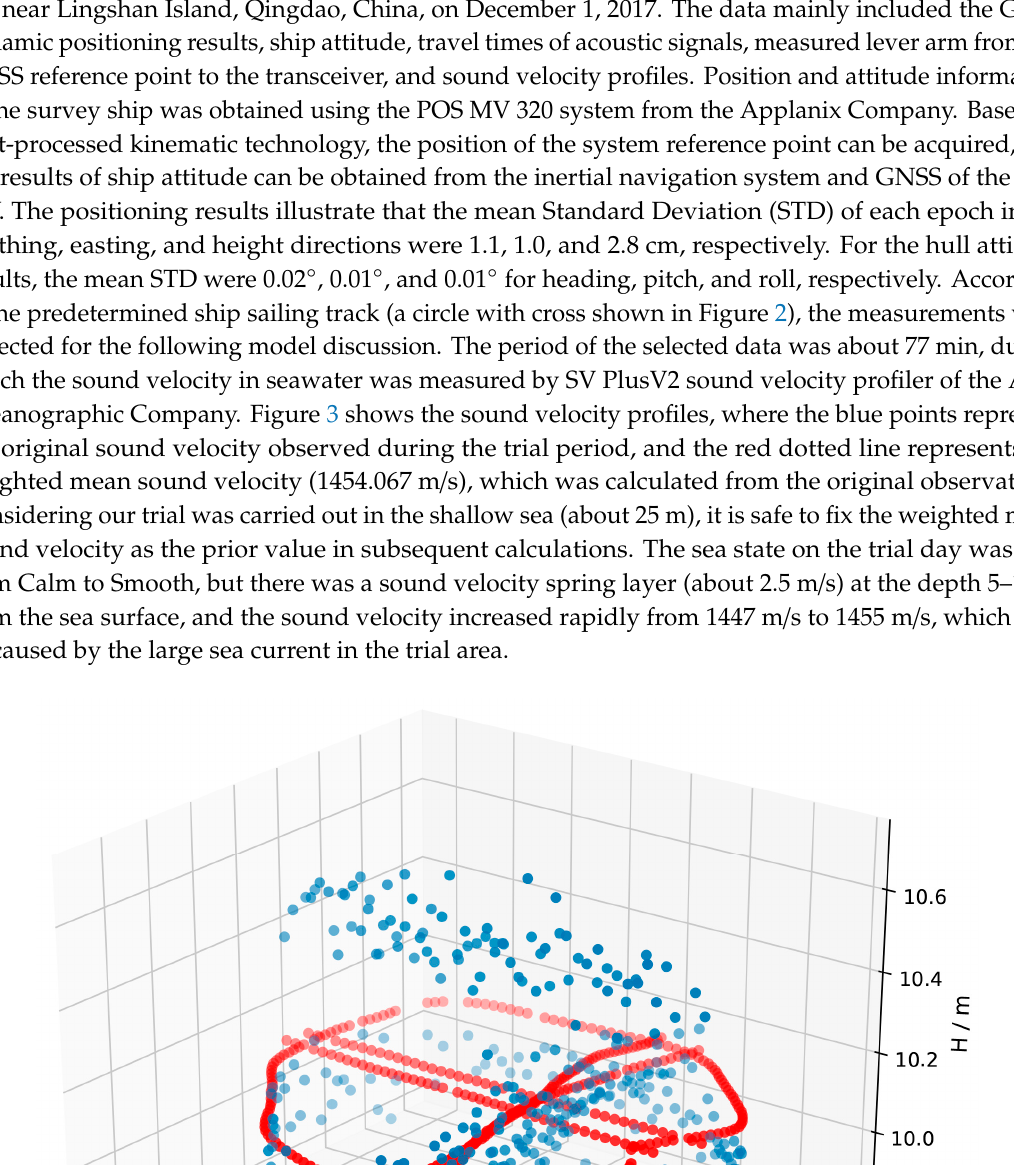
Figure 3. The sound velocity profiles. The observation data were processed by the NEH, NEH+dxyz, and NEH+dv models, and their results are summarised in Table 1. According to the table, significant differences in the three model’s results were observed, especially in the vertical direction. The NEH model’s results feature a higher 1447